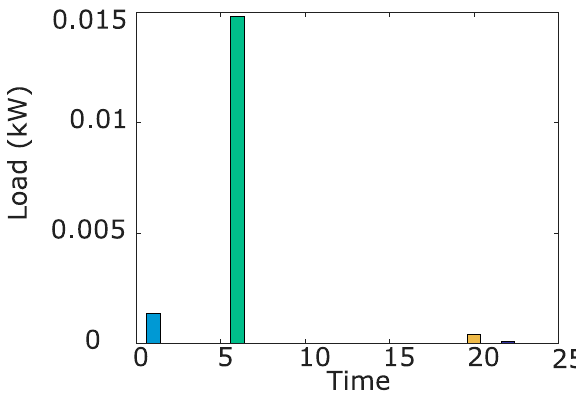
Figure 5. Scheduling of loads with response to demand.